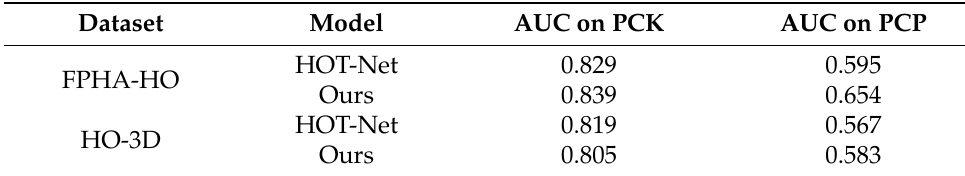
Table 2. Comparison with state-of-the-art methods on both FPHA-HO and HO-3D using the AUC scores (Higher is better) on 3D PCK curve and PCP curve.